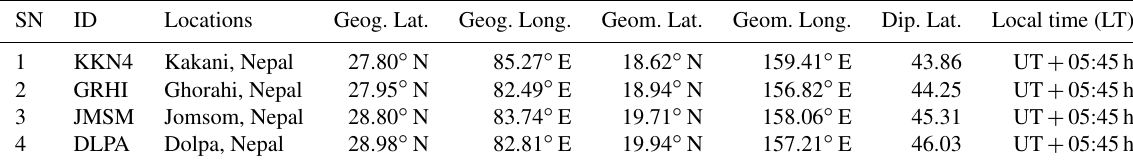
Table 1. The selected GPS stations and their coordinates, the data of which are used in the study. SN ID Locations Geog. Lat. Geog. Long. Geom. Lat. Geom. Long. Dip. Lat. Local time (LT) 1 KKN4 Kakani, Nepal 27.80 ◦ N 2 GRHI Ghorahi, Nepal